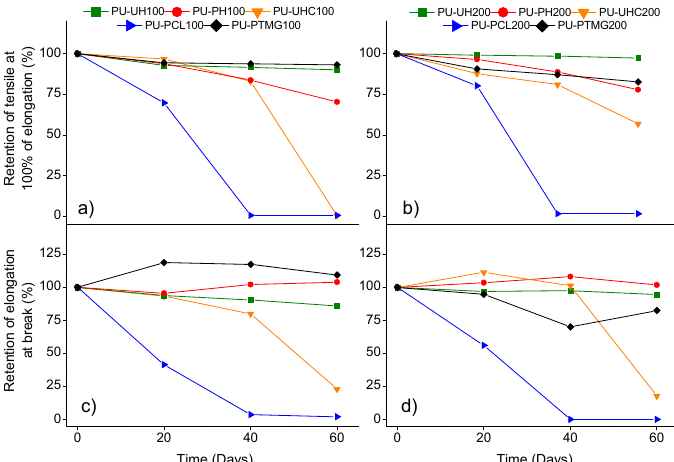
Figure 8. Durability test under water resistance: ( a ) and ( b ), retention of tensile strength at 100% of elongation; ( c ) and ( d ), retention of elongation at break.